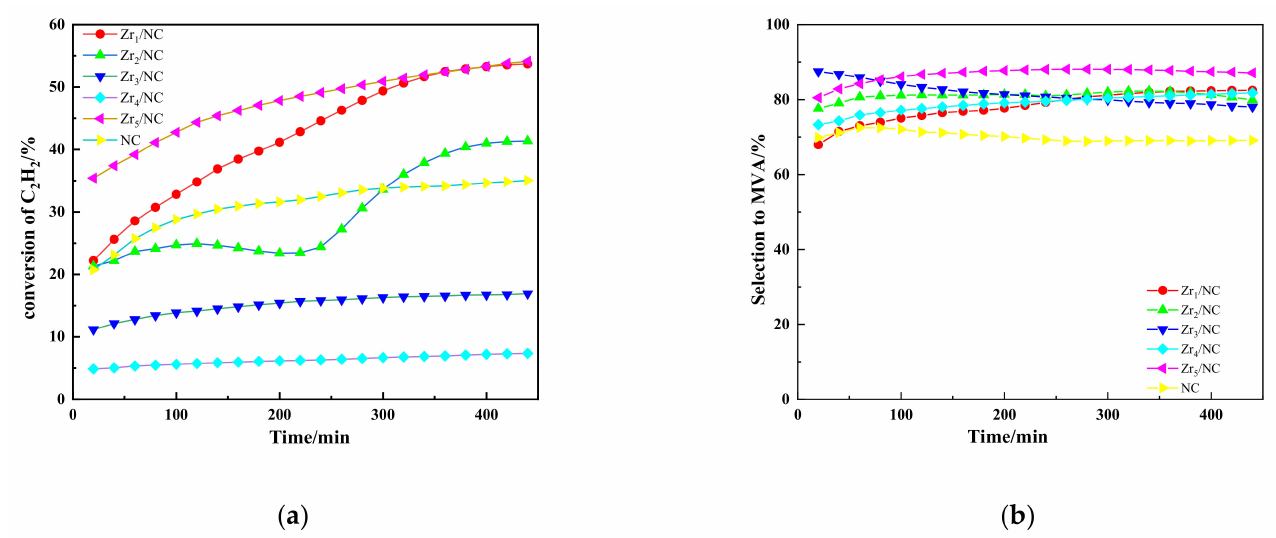
Figure 1. Catalytic performance of NC and Zr X /NC. ( a ) C 2 H 2 conversion with time on stream, and ( b ) MVA selectivity with time on stream.Reaction conditions; temperature (T) = 80 ◦ C and C 2 H 2 gas hourly space velocity (GHSV) = 110 h − 1